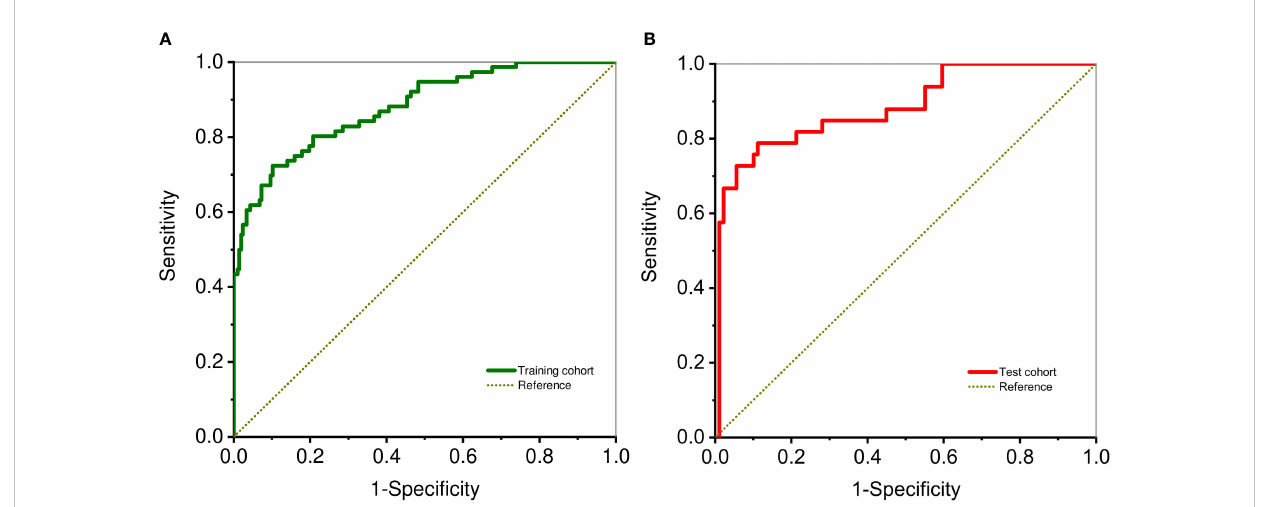
FIGURE 3 ROC curve analysis shows diagnostic ability DLCT-based nomogram in training (A) and test cohorts (B) .